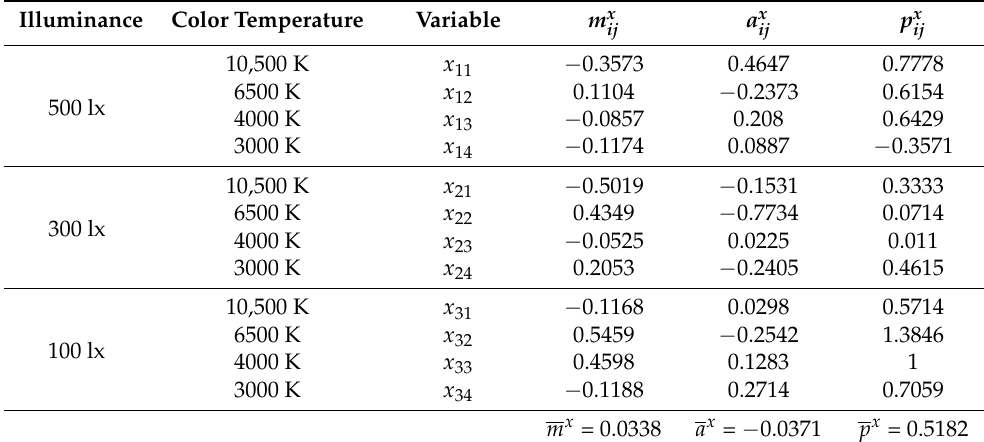
Table 2. Grouping of variables for each parameter of the classroom lighting characteristic.